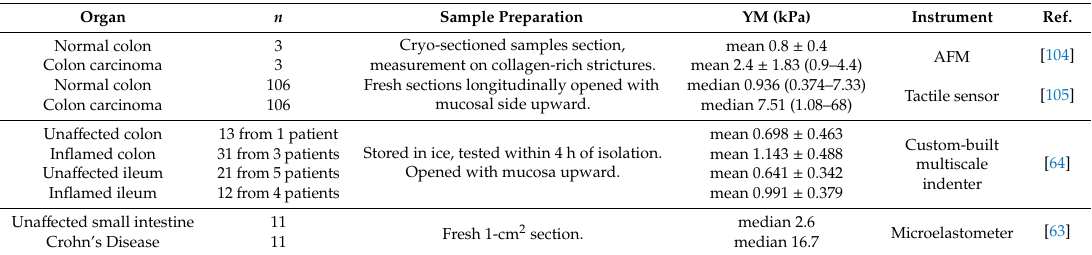
Table 3. Summary of sample preparations and instruments used to determine the Young modulus (YM) in normal and inflamed or cancerous colons and intestines. AFM: atomic force microscopy. Organ n Sample Preparation YM